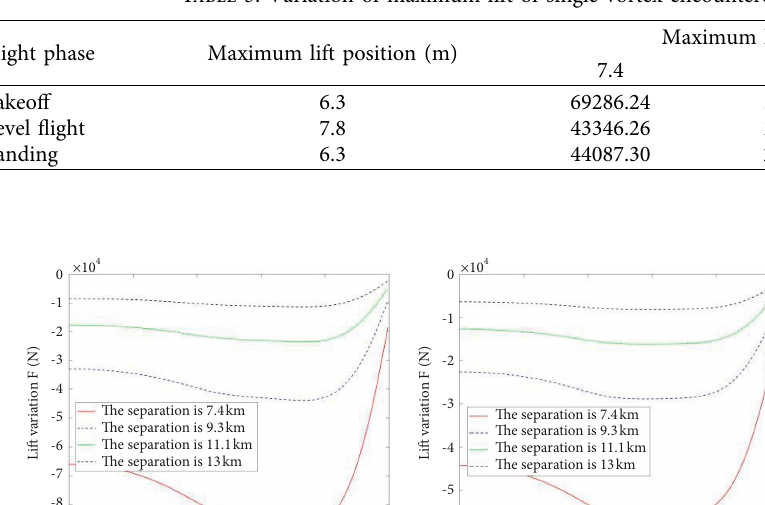
Figure 7: Variation curve of lift of a single wake vortex with the position of the aircraft from the vortex core. (a) Take off phase. (b) Level flight phase. (c) Landing phase. Table 5: Variation of maximum lift of single vortex encountered in longitudinal direction.